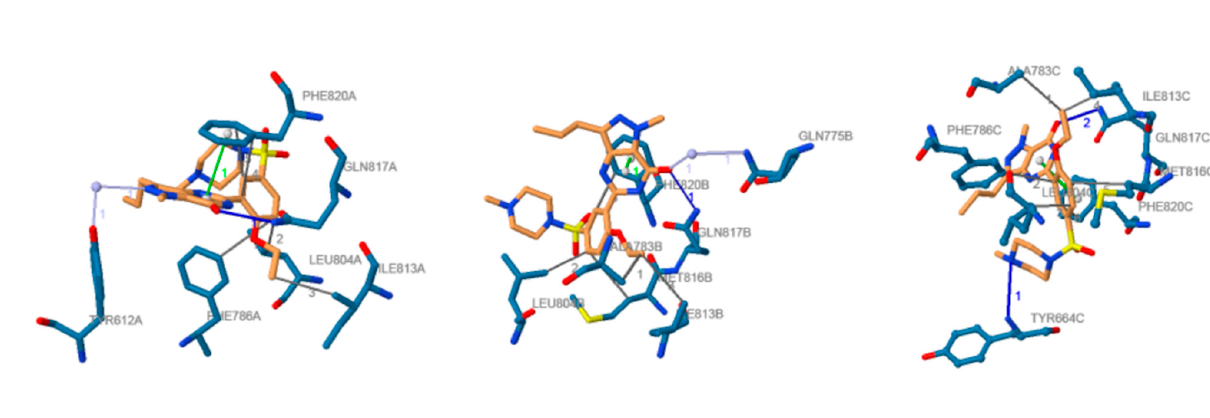
Figure 2. Docked position of sildenafil in the PDE-5 active site: ligand is represented in orange; amino acid residues in blue; hydrogen bonds are shown as solid blue lines; face-to-face stacking interaction in solid green lines; hydrogen bonds in dark solid grey lines; water bridges are represented in light solid grey lines. Image from the PLIP web service [20] using the PDB ID 2H42 [18].